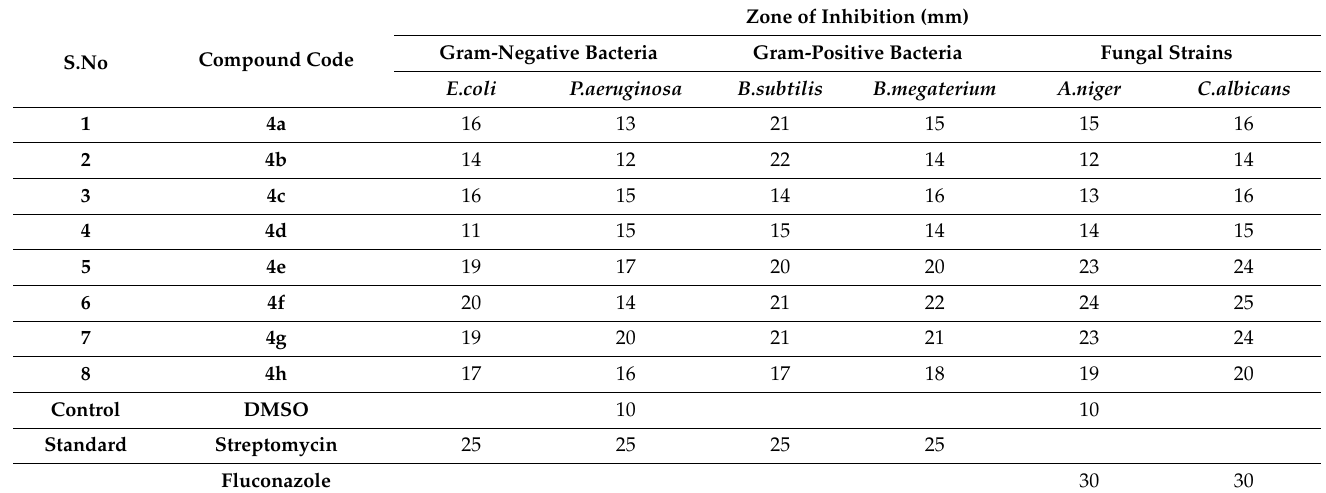
Table 3. In vitro antibacterial and antifungal screening study of the title compounds 4a – 4h